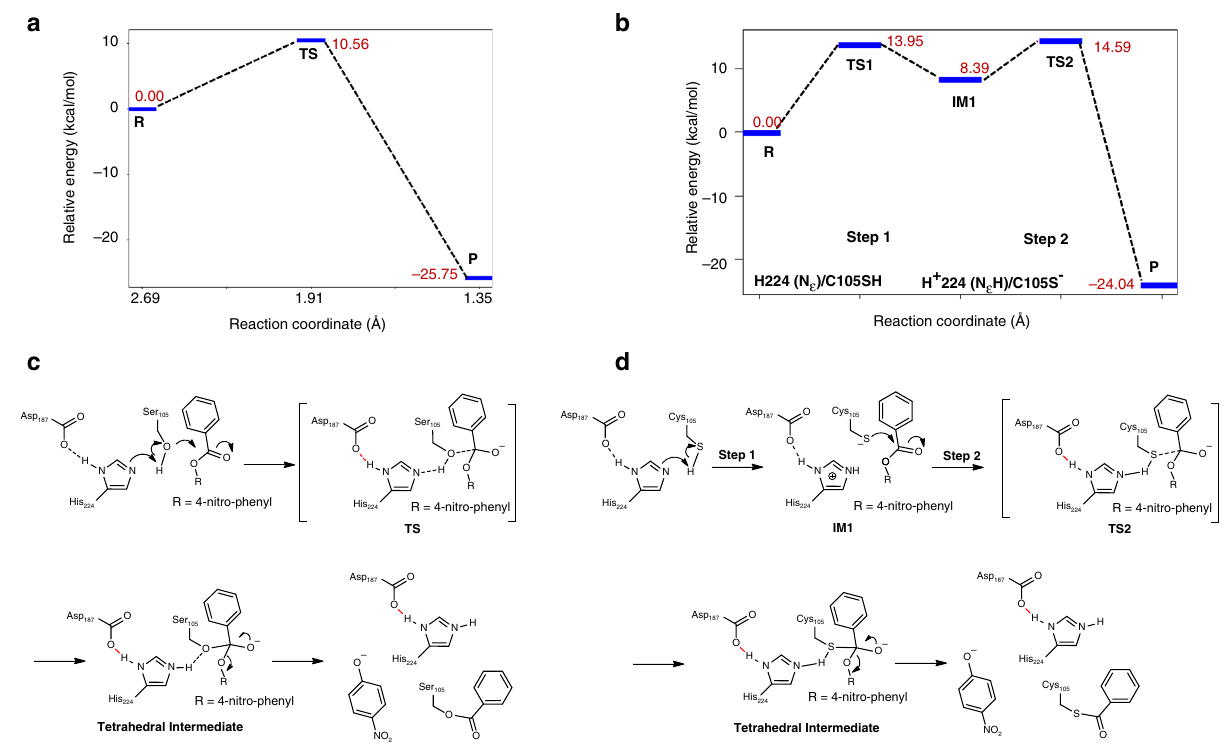
Fig. 5 Different reaction pro fi les of the normal CALB variant QW10 and cysteine-CALB variant QW4. a and c , The normal CALB variant QW10 adopts a concerted mechanism of simultaneous proton transfer and nucleophilic attack. b and d , For the cysteine-CALB variant QW4, the formation of the tetrahedral intermediate occurs via a two-step reaction mechanism where proton transfer from Cys105 to His224 is followed by a nucleophilic attack of the deprotonated Cys105 to the carbonyl group of the substrate. The reaction pro fi les in the hydrolysis of substrate 1 were calculated by QM/MM (AMBER/ ω B97X-D/6 – 31 G + (d, p)). The reaction coordinate is the distance between the substrate carbonyl carbon and hydroxyl oxygen of Ser105 or thiolate sulfur of deprotonated